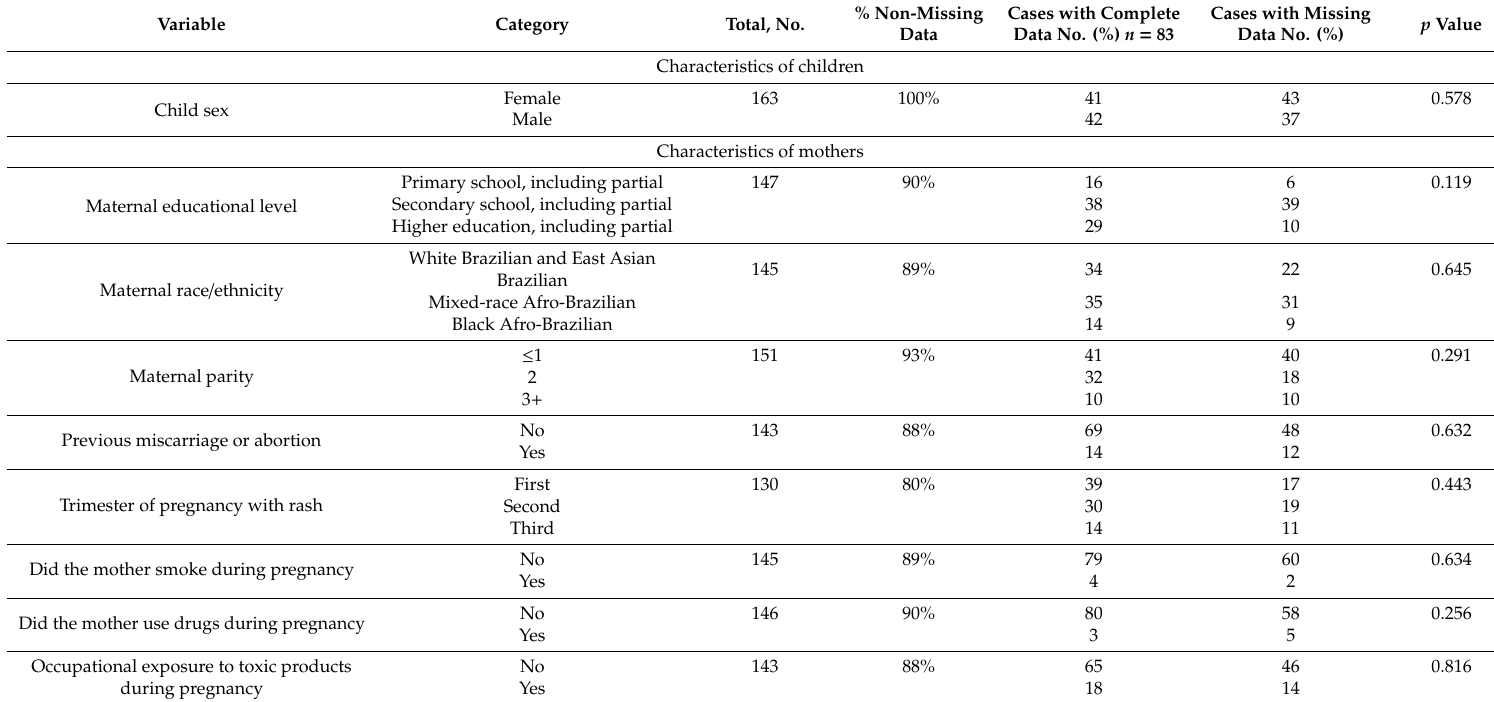
Table A1. Missingness patterns with percentages of missing data for each variable and baseline information stratified into two groups: cases with complete data and cases with missing data ( n =